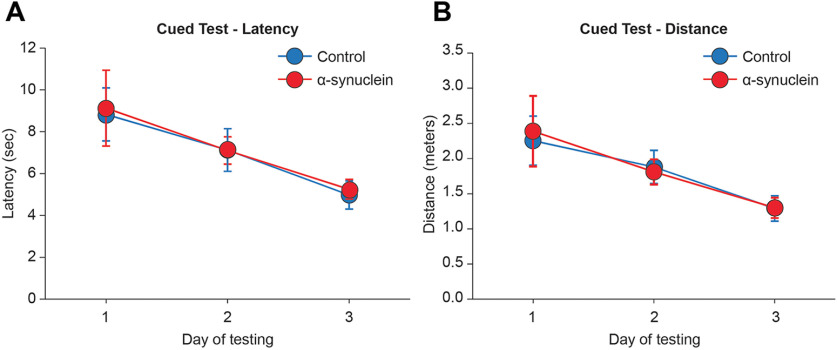
Groups performance during the cued version of the Morris water maze test at three months postinjection. In this task, the visually cued escape platform was moved to a different quadrant on each of the four daily trials, and average escape latencies (A) and swim distances (B) were recorded. Each point represents the mean value ± SEM for the block of four trials administered each day, over the three training days.